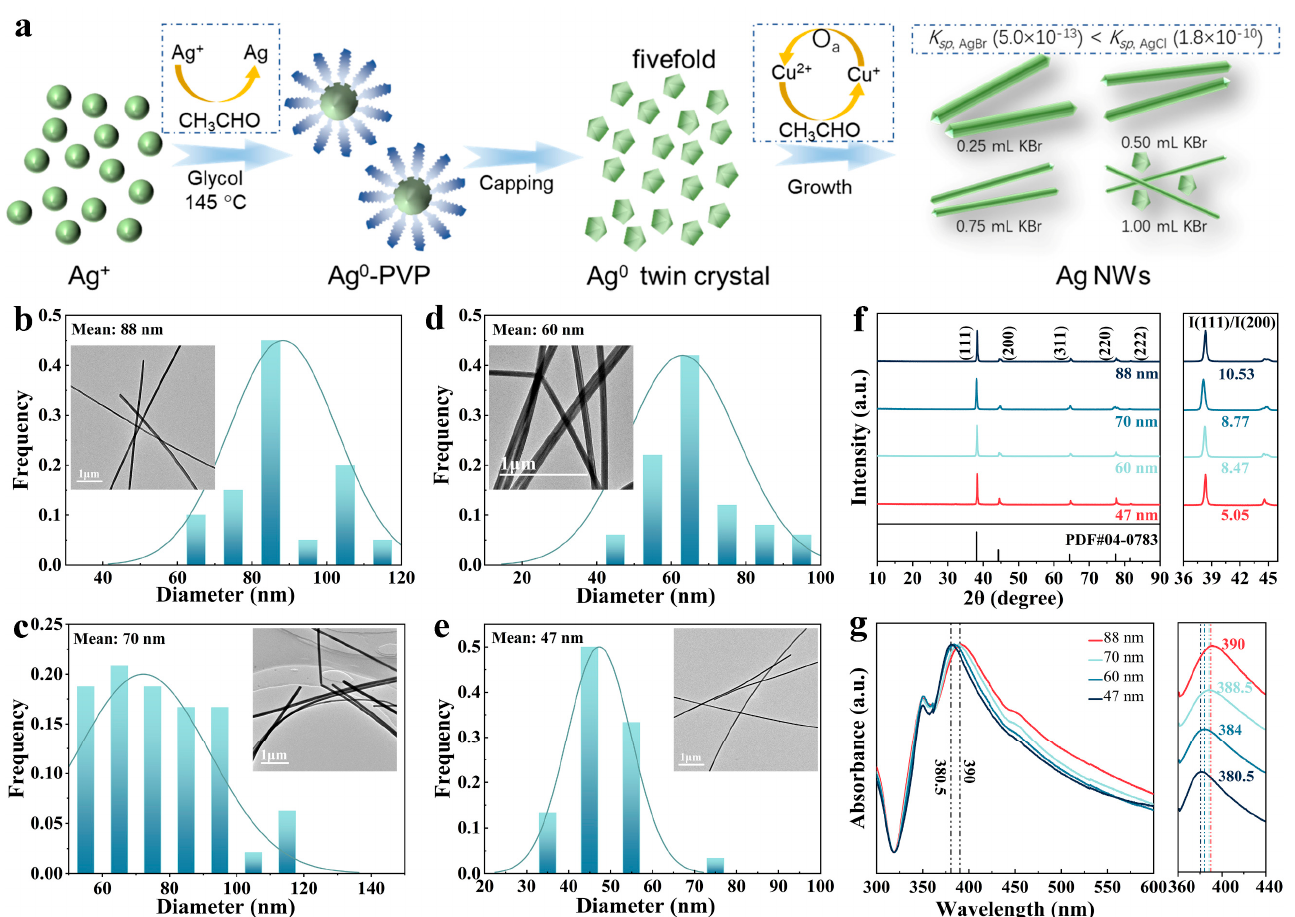
Figure 1. ( a ) Schematic illustration of the synthesis of Ag NWs. The diameter distributions of the Ag NWs synthesized with different amounts of Br − were: ( b ) 0.25 mL; ( c ) 0.5 mL; ( d ) 0.75 mL; and ( e ) 1 mL. Insets: TEM images of the corresponding Ag NWs. ( f ) XRD patterns and ( g ) UV-Vis spectra of the Ag NWs with different diameters.